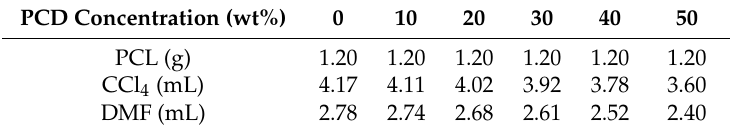
Table 1. The specific components and quantities used in electrospinning precursor